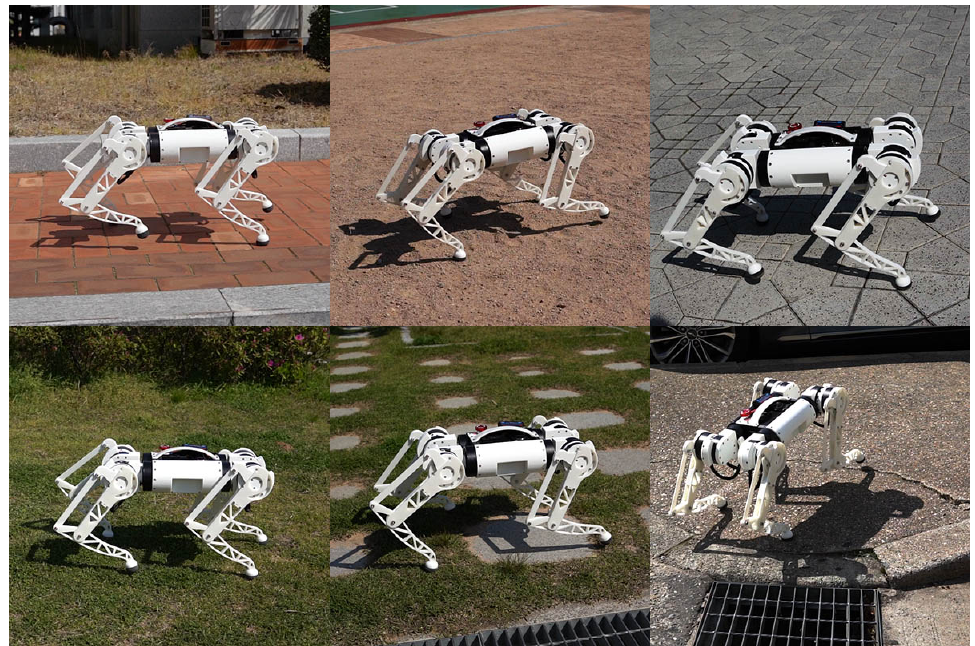
Figure 18. PADWQ walking over various outdoor